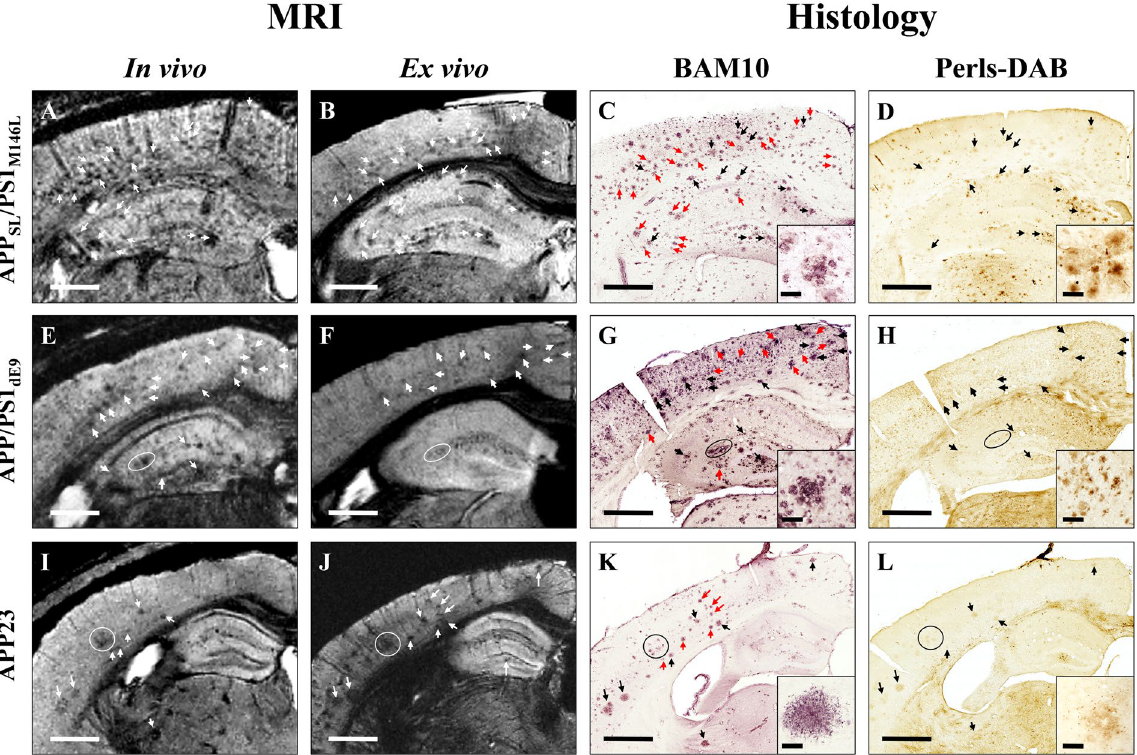
Figure 1. Comparison between detection of amyloid plaques by Gd-stained MRI and immunohistochemistry in APP SL /PS1 M146L , APP/PS1 dE9 , and APP23 mice. Gd-stained in vivo (column 1) or ex vivo (column 2) MR images were registered with β -amyloid (BAM10, column 3) and iron-stained (Perls-DAB, column 4) histological sections in APP SL /PS1 M146L ( A – D ), APP/PS1 dE9 ( E – H ) and APP23 ( I–L ) mice. Inserts in columns 3 and 4 display typical plaques for each strain. Hypointense spots (white arrows and circles) are visible in